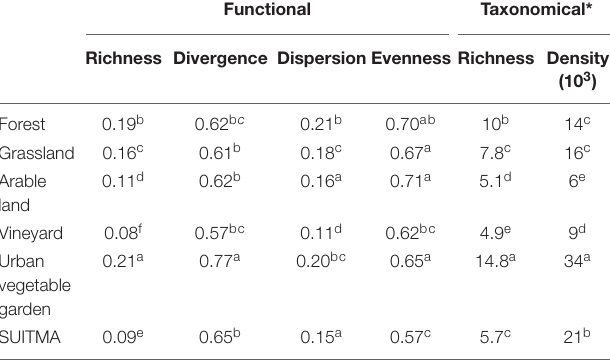
TABLE 5 | Mean values of functional and taxonomic indices calculated on collembolan communities in French topsoils, according to land use: